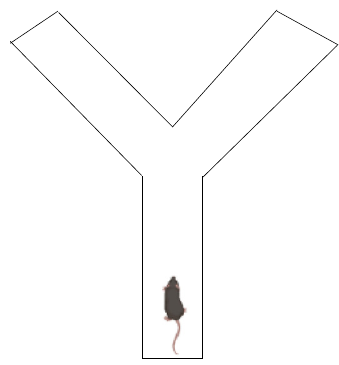
Figure 7. The Y-maze spontaneous test in mice. Working memory is evaluated as in the Barnes maze test. maze